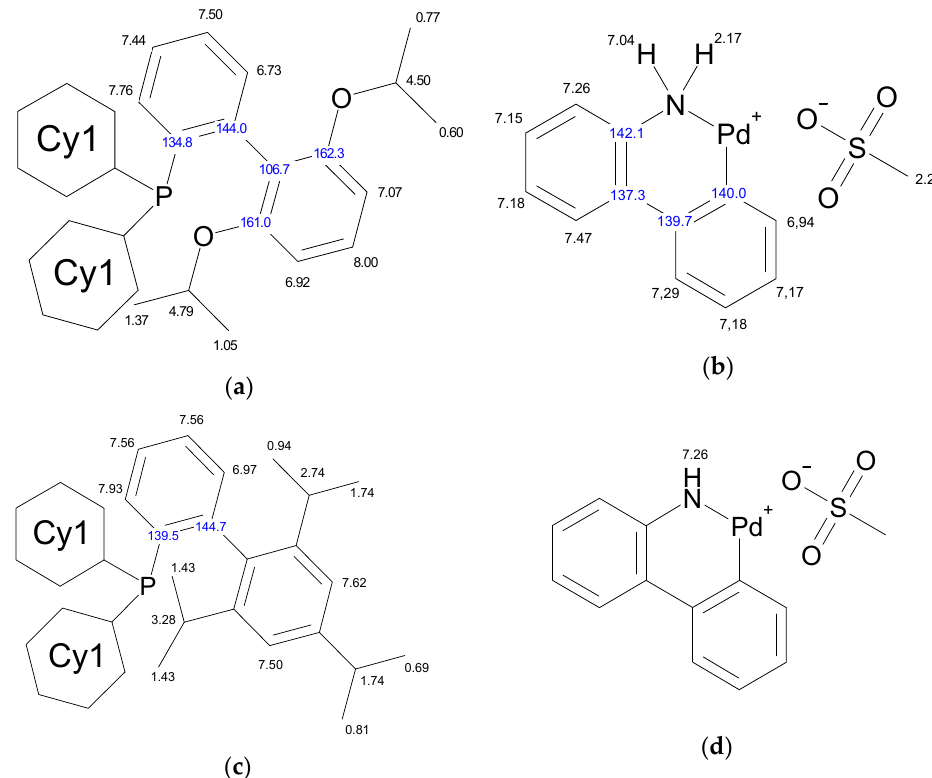
Figure 10. Assignment of the signals specified by their chemical shifts of 1 H (black) and 13 C (blue), of coordinated RuPhos in RuPhos Pd G3 ( a ), ABP - fragment in RuPhos Pd G3 ( b ), coordinated XPhos in XPhos Pd G3 ( c ) and NH 2 -group of ABP in XPhos Pd G3 ( d ), based on 1D and 2D NMR experiments in DMSO- d 6 .